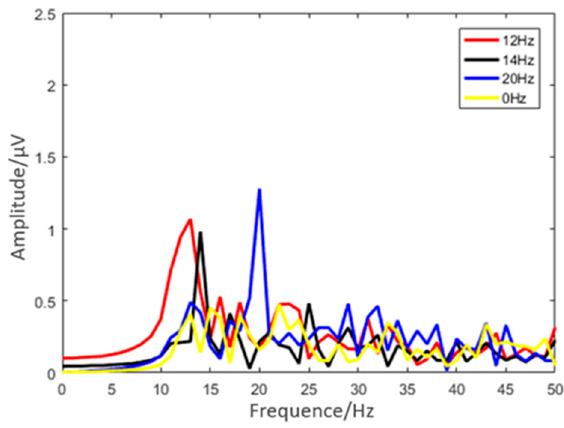
Figure 11. Results of the SSVEP experiment under different stimulus frequencies (12 Hz, 14 Hz, and 20 Hz).